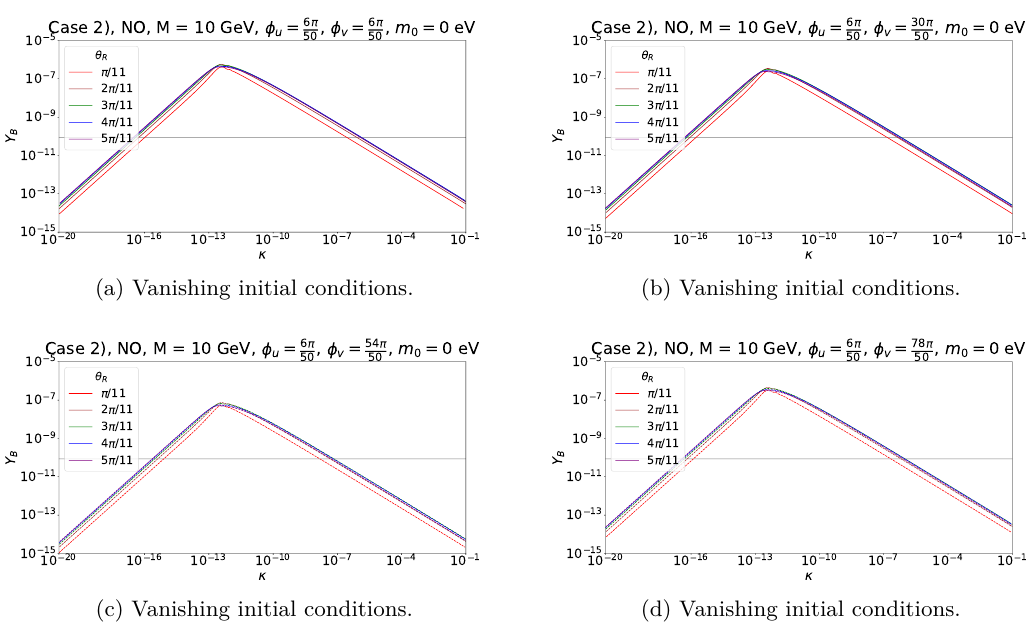
Figure 13 . Case 2) Y B as function of κ for a Majorana mass of M = 10 GeV and for n = 50 and the parameters ( s, t ) equal to (4 , 2) (upper left plot), (8 , 10) (upper right plot), (12 , 18) (lower left plot) and (16 , 26) (lower right plot). Light neutrino masses have strong NO. For the remaining choices see figure 12.